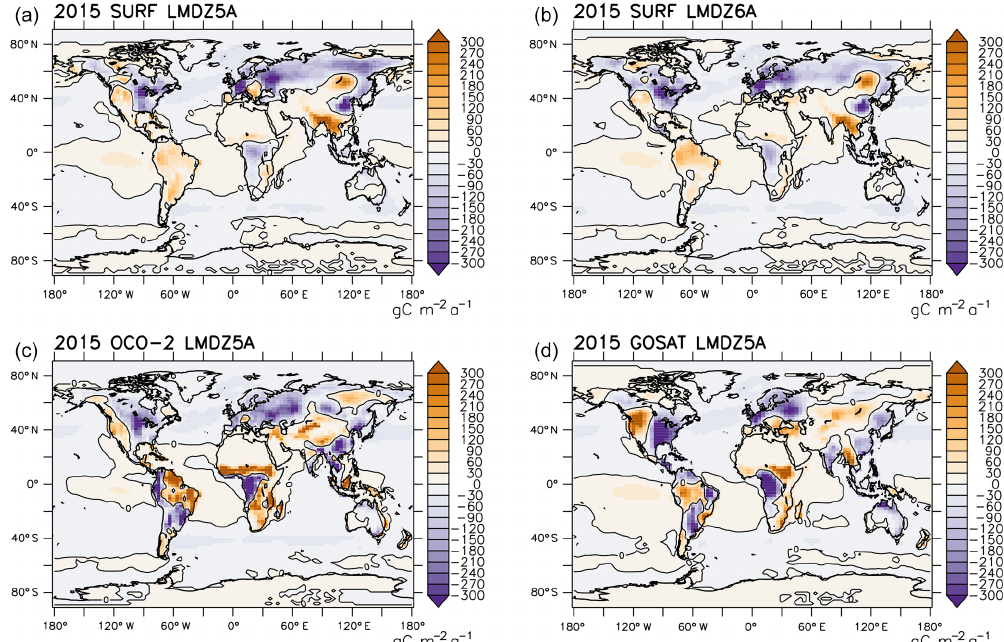
Figure 6. Grid-point budget of the natural CO 2 fluxes for the year 2015. In the sign convention, positive fluxes correspond to a net carbon source into the